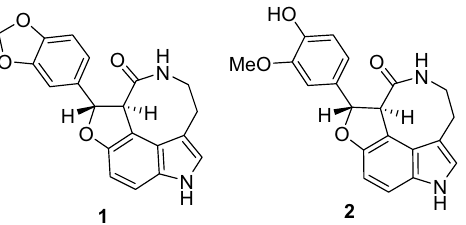
Figure 1. Chemical structures of naturally occurring (+)-decursivine 1 and (±)-serotobenine 2 .